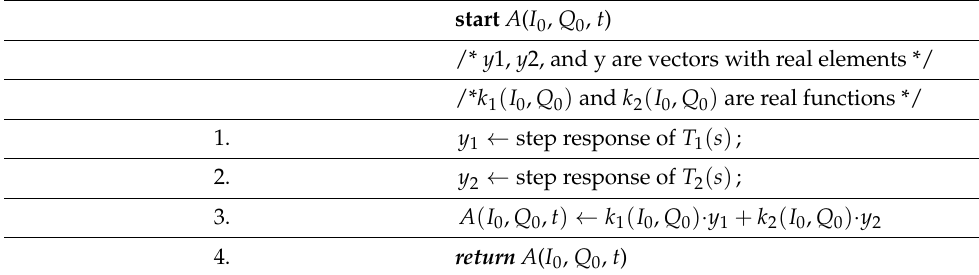
Table 1. Outline of function A ( I 0 , Q 0 , t